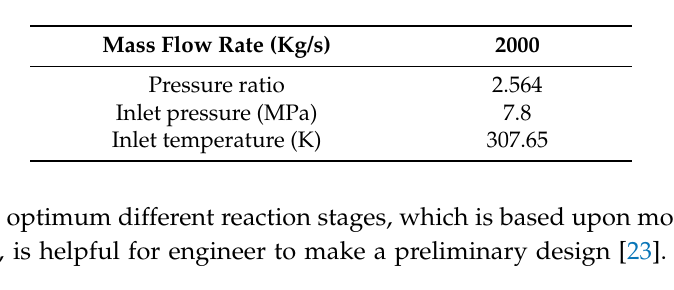
Table 3. Design parameters for the axial